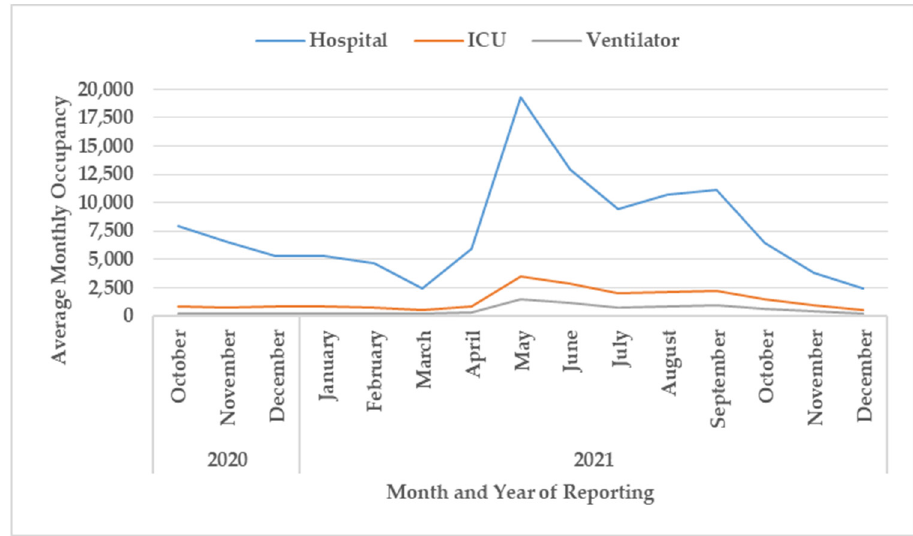
Figure 6. Monthly bed occupancy for hospitals treating severe cases of COVID-19, intensive care units, and mechanical ventilation in Kerala, October 2020 to December 2021. ICU = intensive care unit; Ventilator = mechanical ventilation.